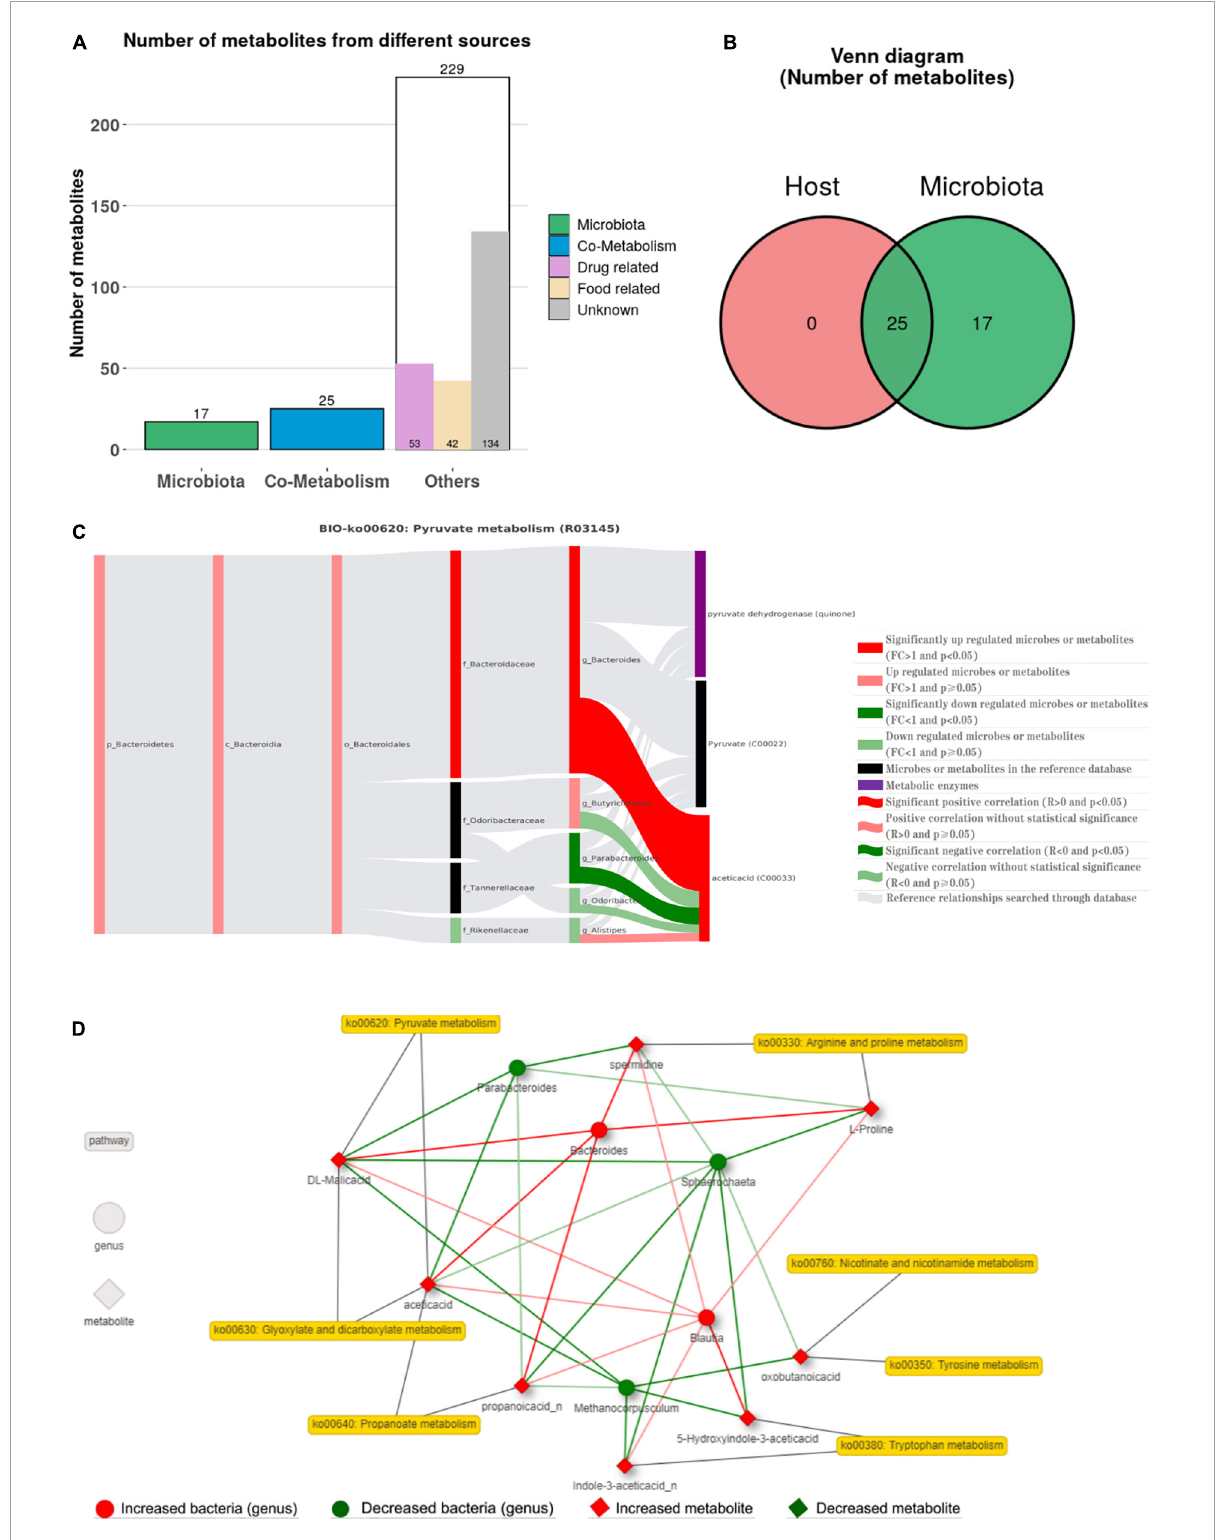
FIGURE6 Correlation analyses between microbes and metabolites. (A) Venn diagram of the number of metabolic pathways in microbial community. (B) Venn diagram of the number of metabolites in bacterial communities. (C) The BIO-Sankey Network for R03145 metabolic reaction in pyruvate metabolism. (D) Network summary of co-metabolism pathways between metabolites and